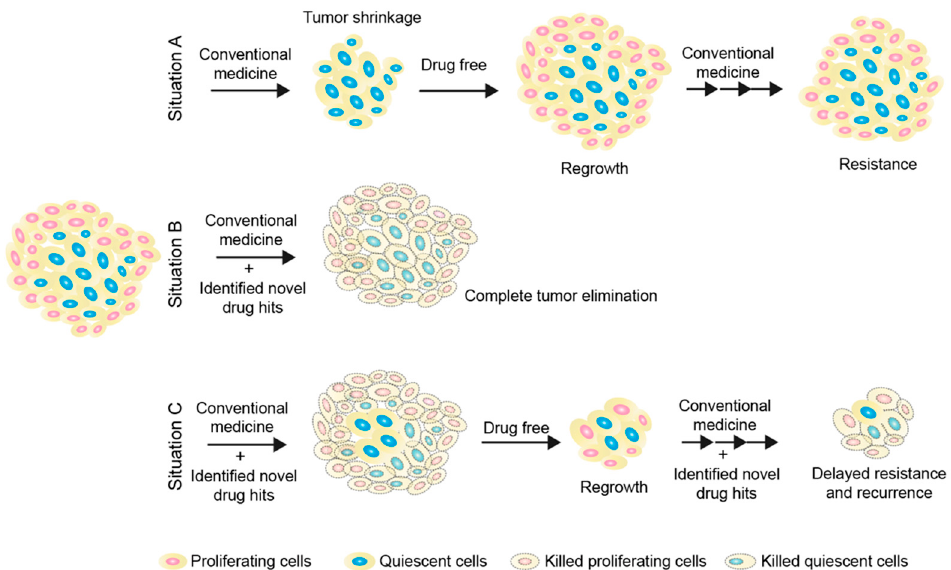
Figure 2. Elimination of tumor cells by targeting both proliferative and quiescent cancer cell populations. Situation ( A ) describes the current clinical obstacle in the treatment of solid tumors due to the existence of quiescent cancer cells, which are insensitive to cell-cycle-active drugs (Figure 1). Situation ( B ) describes an ideal outcome by targeting both proliferative and quiescent cancer cell populations. Briefly, proliferative cancer cells could be targeted by cell-cycle-dependent anticancer reagents and quiescent cancer cells could be removed by small-molecule drugs or immunotherapies developed from strategy 3. Situation ( C ) describes a feasible strategy. In brief, targeting both proliferative and quiescent cancer cell populations has a better chance of removing a larger proportion of tumor cells compared to Situation A . During the drug-free period, residual tumors will regrow, but fewer latent cells could result in smaller regrowth tumors. Re-expanded tumors can be re-treated by targeting both proliferating and quiescent cancer cell populations. This strategy could be able to delay the onset of drug resistance and tumor recurrence, thereby prolonging survival expectations.